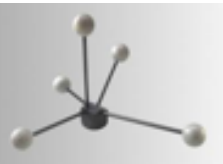
Figure 5: Target balls used for tracking